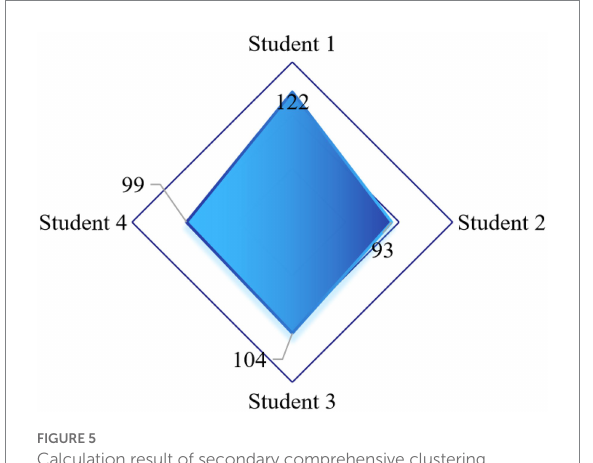
FIGURE 5 Calculation result of secondary comprehensive clustering